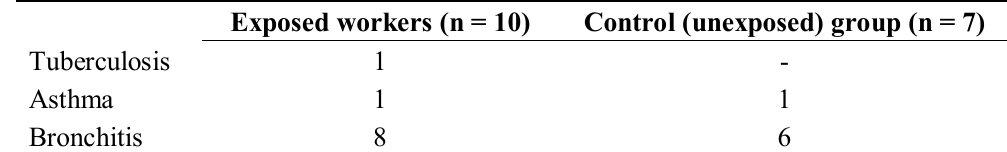
Table 4. Tuberculosis, asthma, bronchitis among the exposed workers and control (unexposed) group.